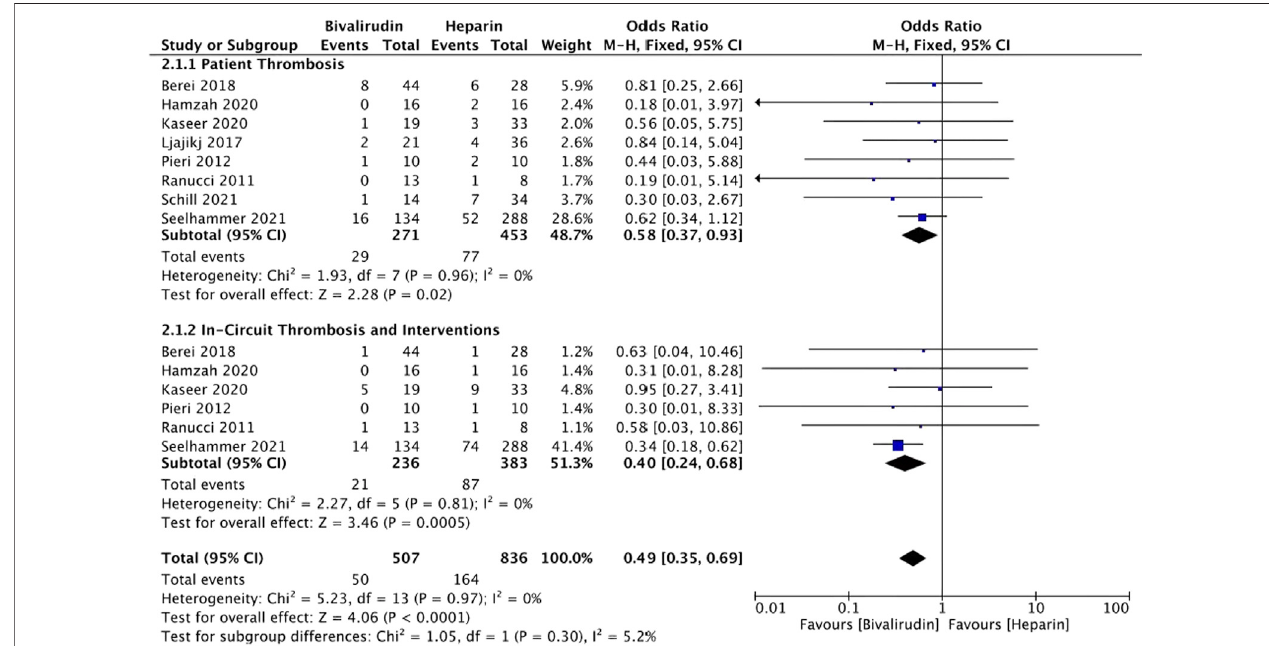
FIGURE 3 | The incidence of thrombosis between the bivalirudin group and the heparin group.